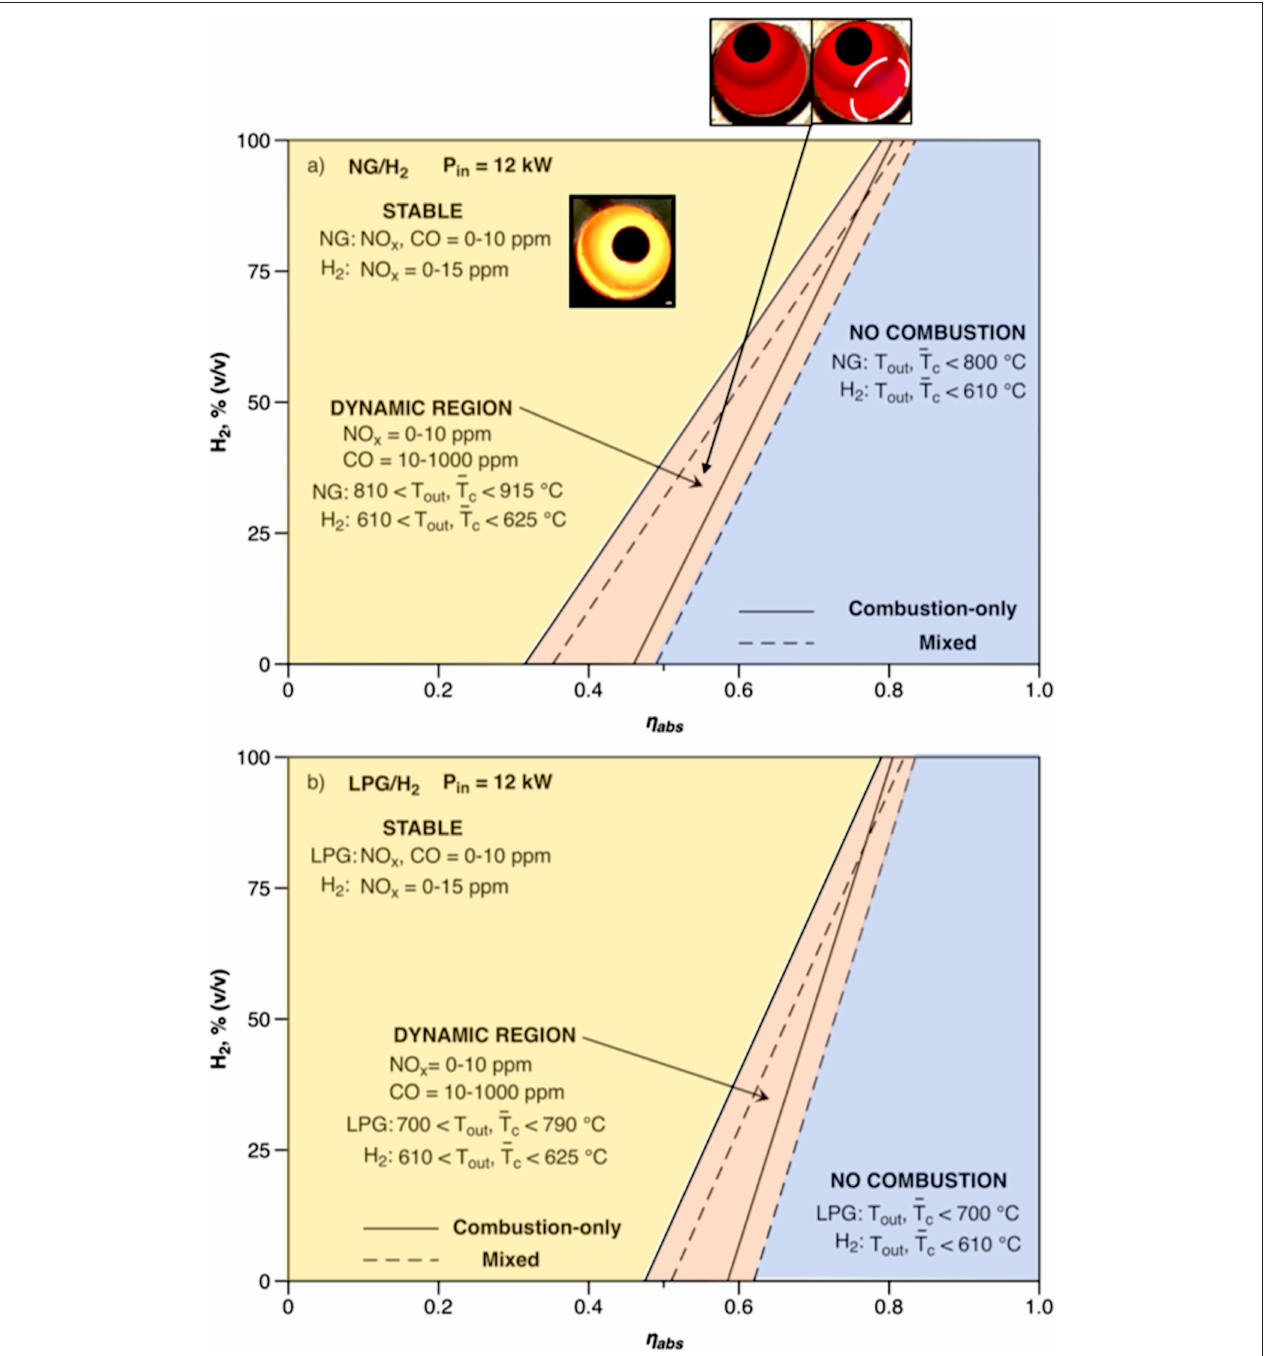
FIGURE 9 | Experimental stability maps for combustion-only and mixed operations, and for (a) NG/H 2 and (b) LPG/H 2 mixtures ( P in = 12 kW, φ = 0.9). The deduced boundaries for each system behavior are based on ∼ 100 data points for each fuel. Typical in-furnace images for stable MILD and dynamic behavior are also reported (photos taken during combustion-only modes with the aperture open prior to switch to mixed operations). Data from Chinnici et al. (2018b).